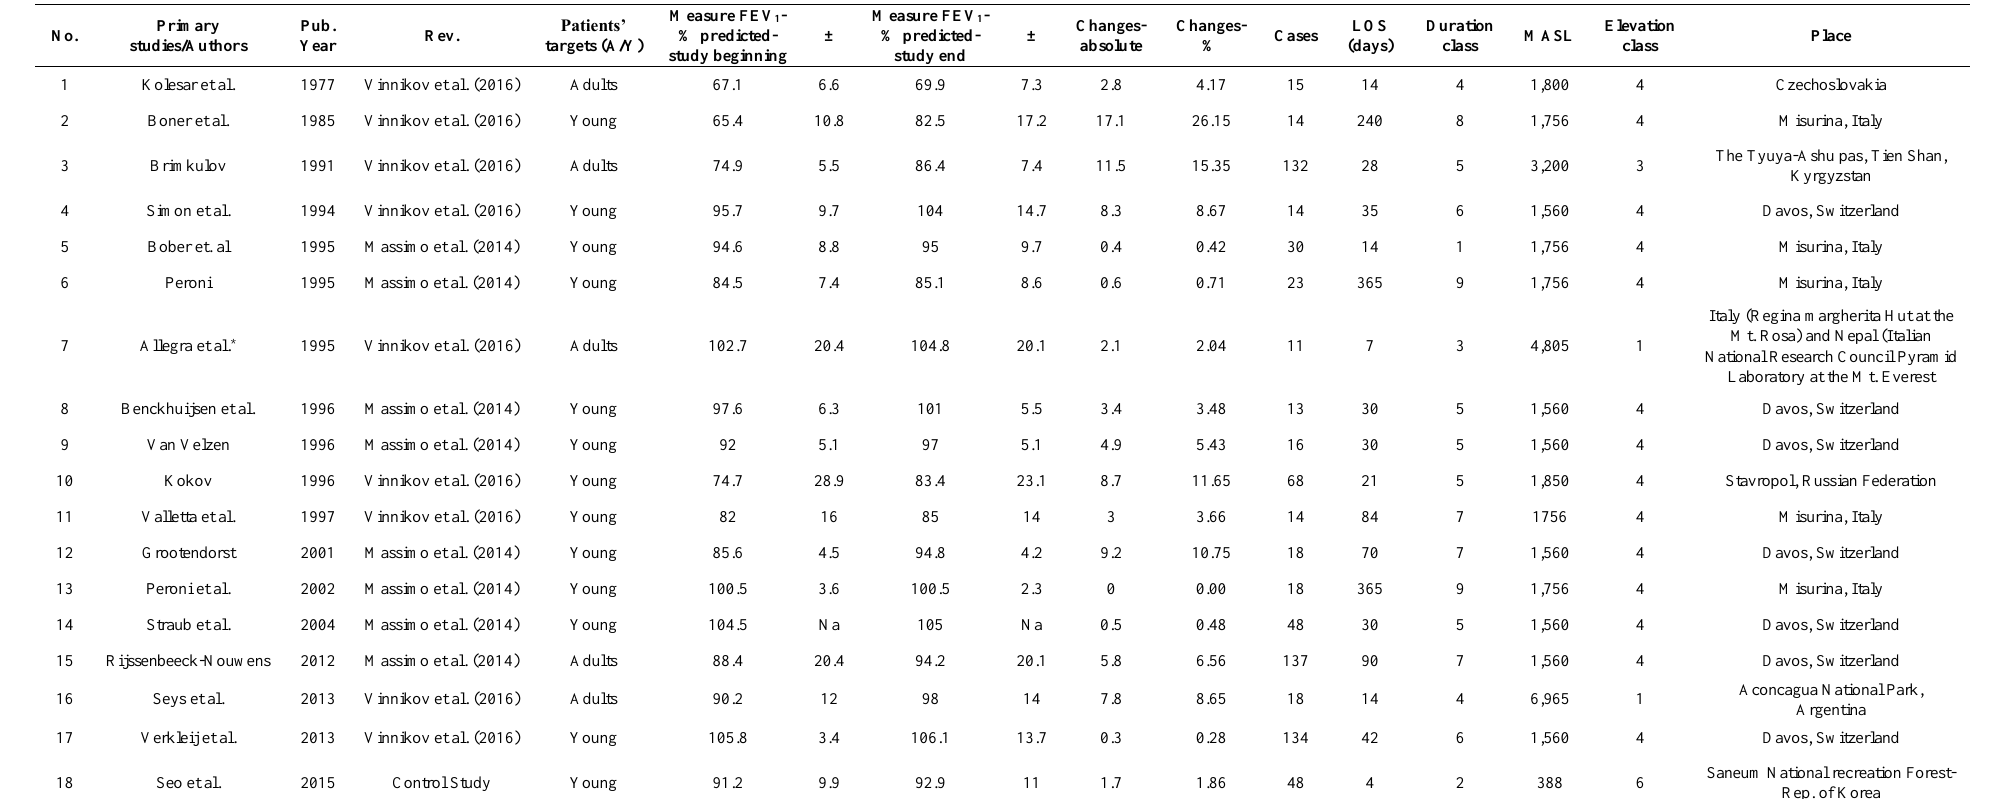
Table 1. The key features of adopted previous primary studies and the